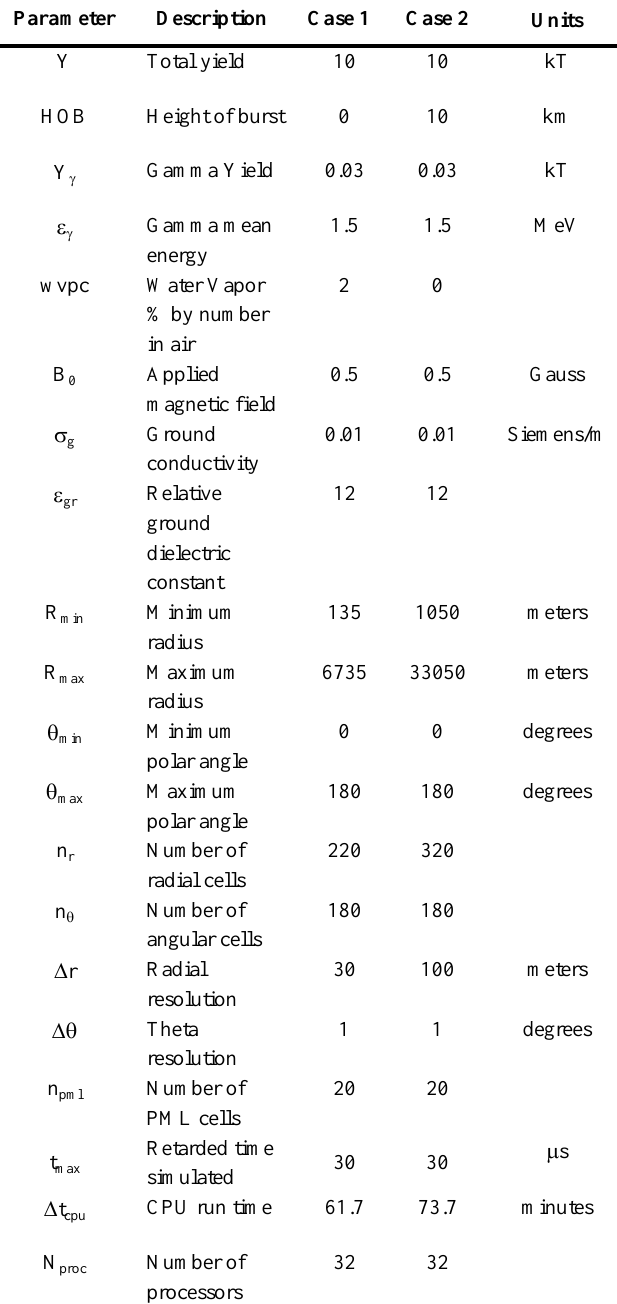
Table 1: Run parameters for two